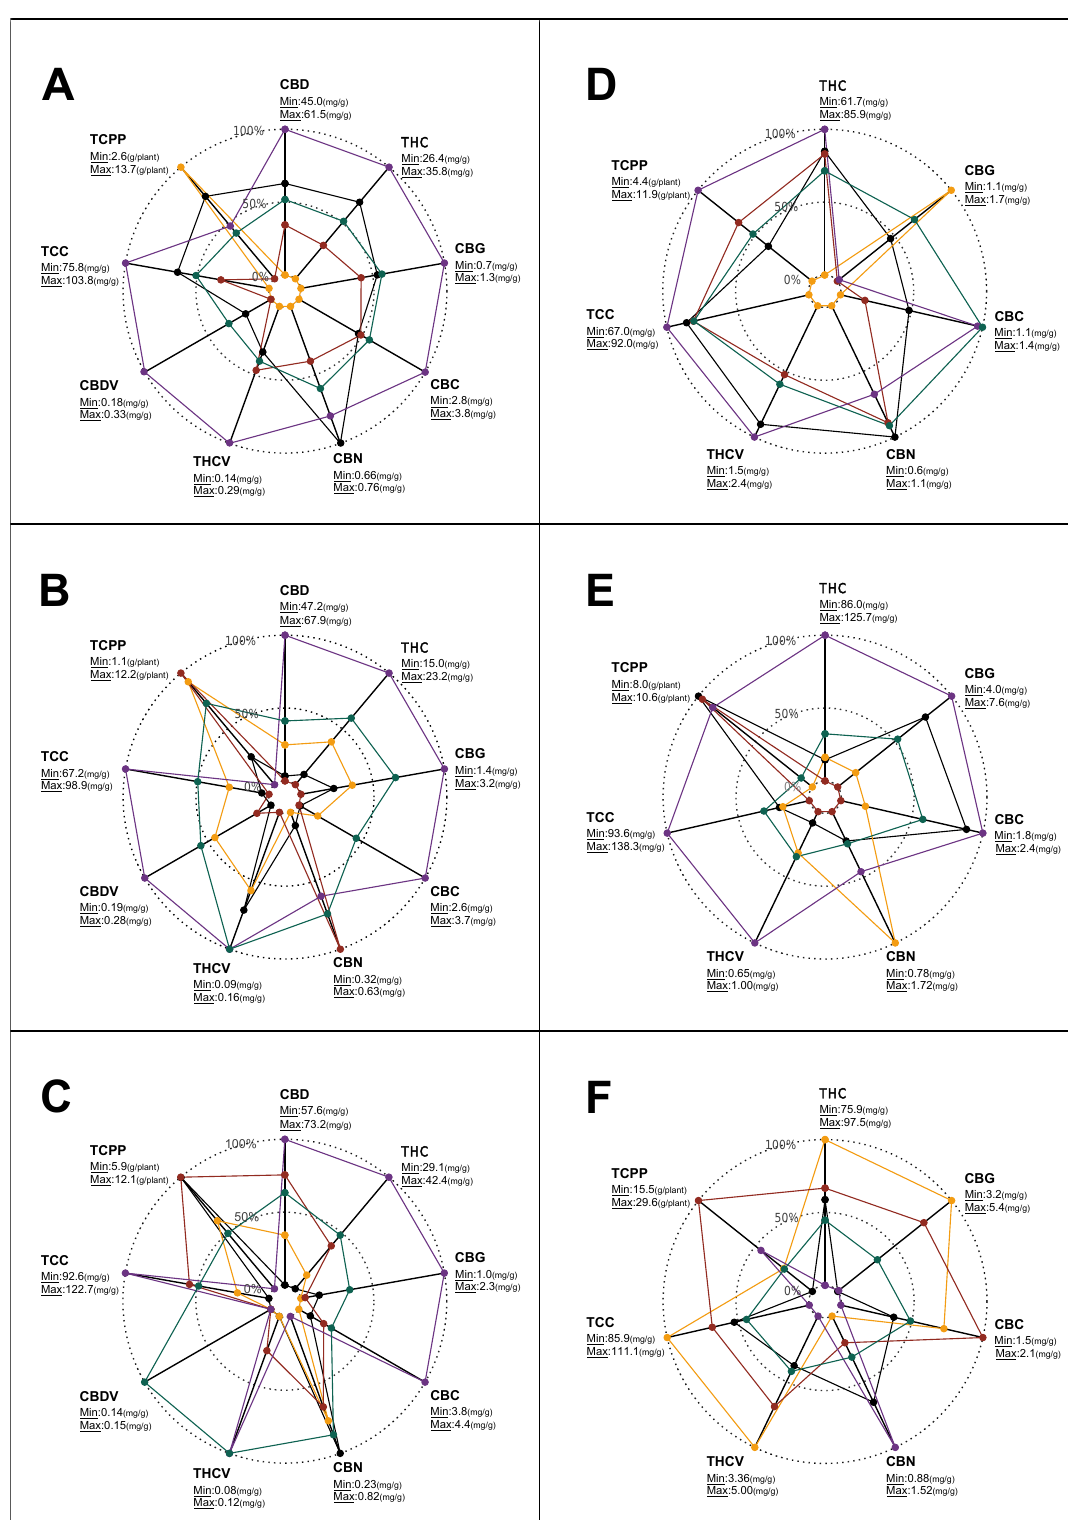
Figure 5. Radar charts for the relative quantities of cannabinoids recorded for 5 replicates (marked by colours) of 6 genotypes ( A – F ). The absolute range of cannabinoid quantities, minimum (0%) and maximum (100%), is presented next to each of the recorded